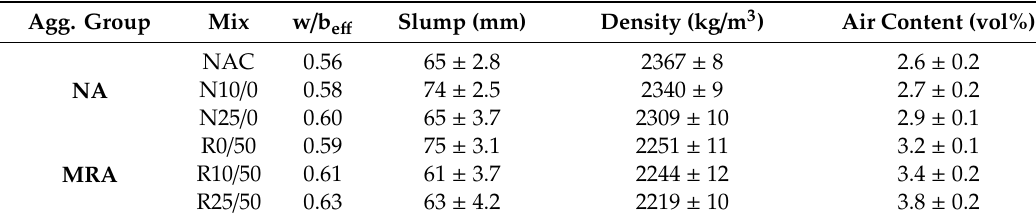
Table 7. Fresh-state concrete properties ( ± : standard